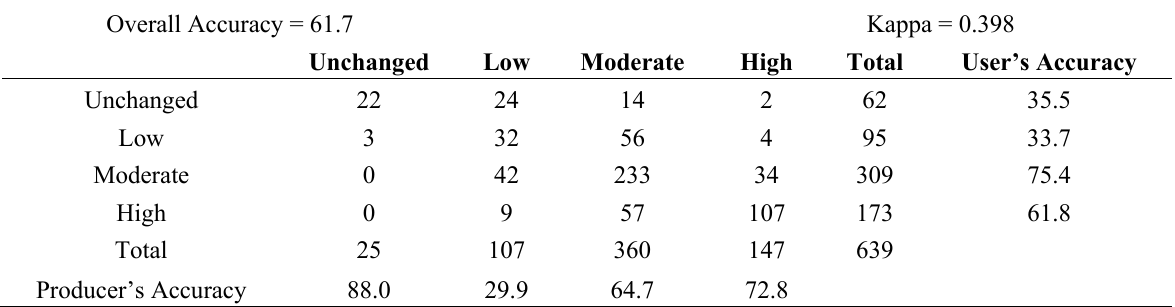
Table 10. Confusion matrix for field data (columns) and RdNBR pixel values (rows). Overall Accuracy =